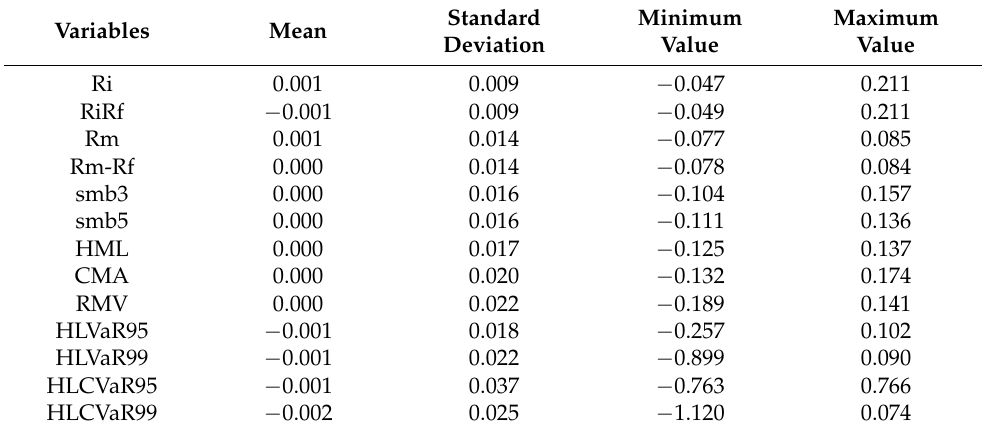
Table A1. Descriptive Statistics of Risk